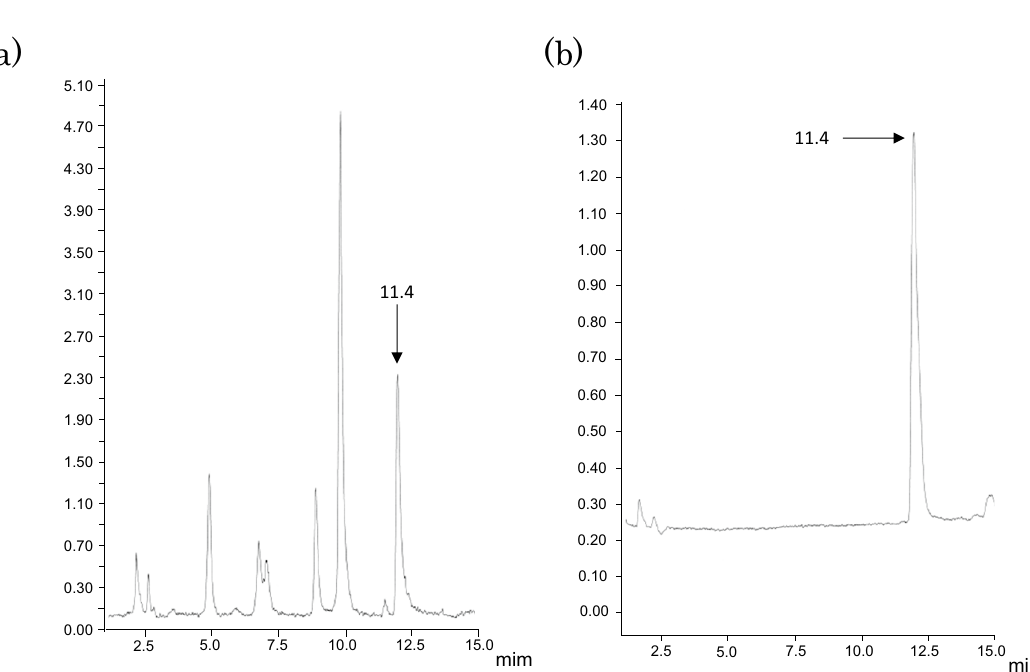
Figure 7. LC–MS chromatogram. ( a ) Aglycons liberated by acid hydrolysis. ( b )